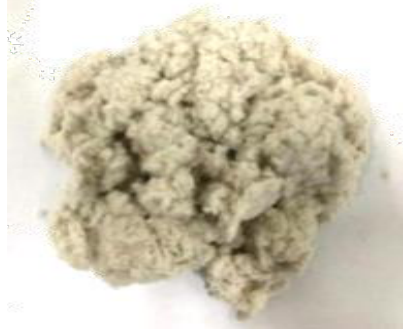
Figure 2. Lignin fiber. Table 3. Properties of basalt fiber and lignin